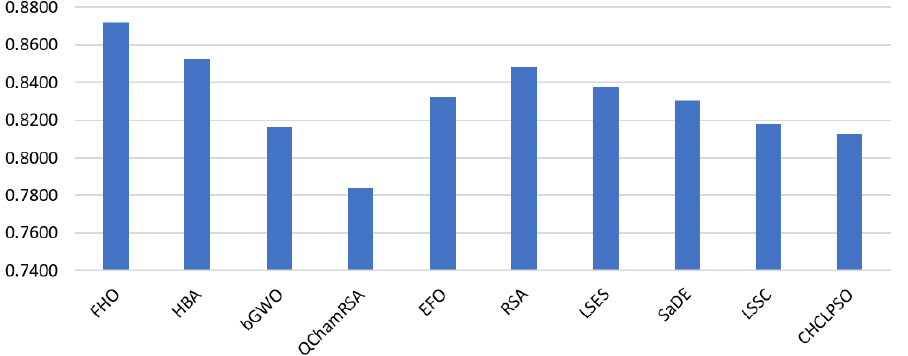
Figure 3. Average of the precision measure in the binary